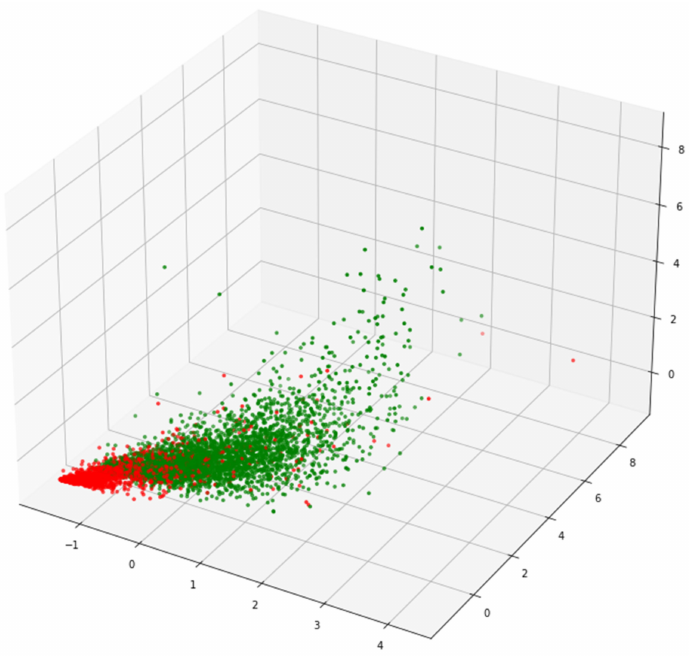
Figure 2. Visualizing clustering